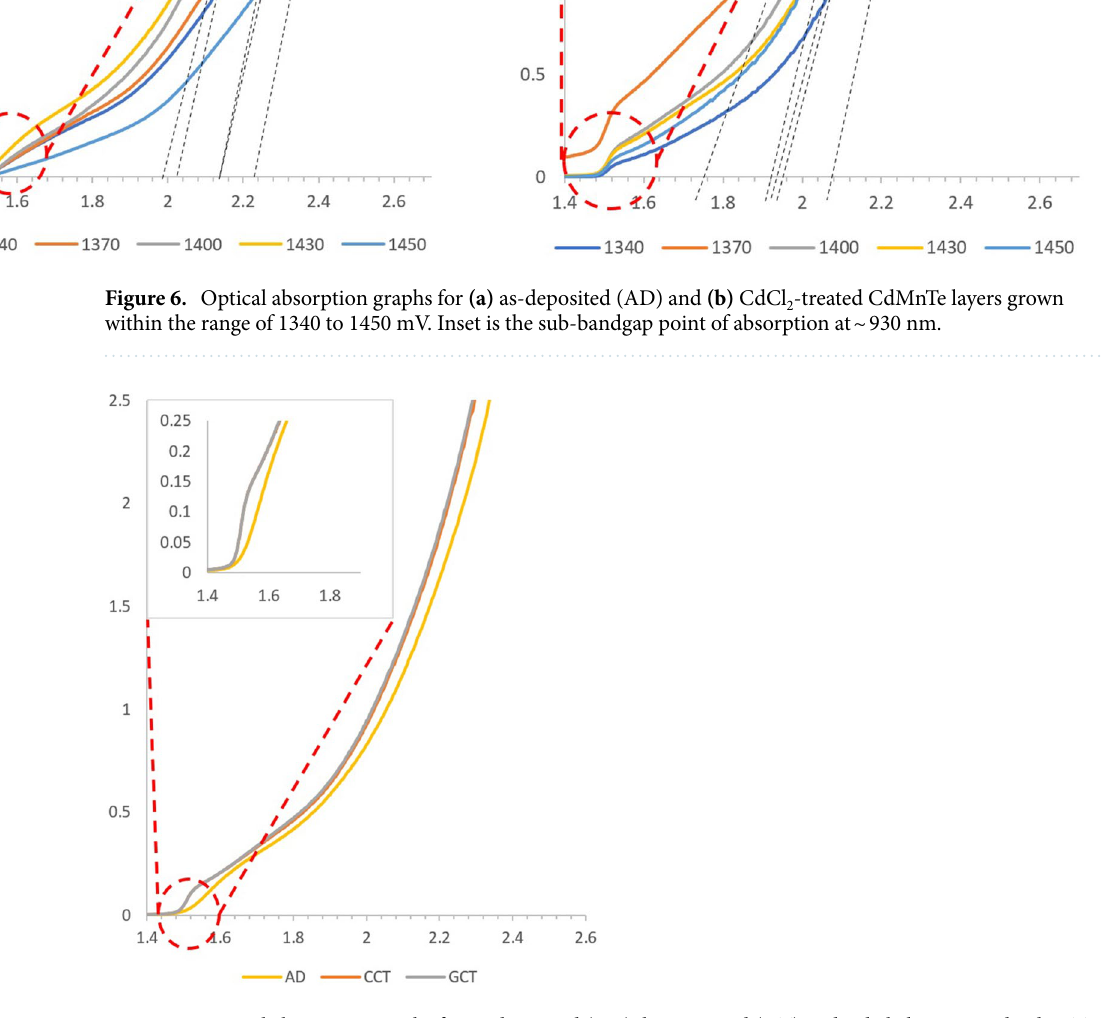
Figure 7. Optical absorption graphs for as-deposited (AD), heat-treated (HT) and CdCl 2 -heat treated CdMnTe layers grown at 1430